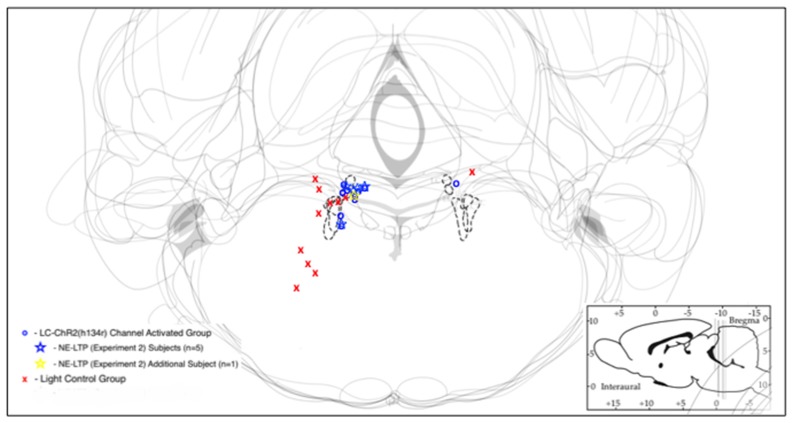
Schematic representations of LC with optrode placements designated by symbols. Blue/yellow symbols represent optrode placements that successfully produced light activation of the recorded cells. Red symbols indicate optrodes that did not produce light activation of recorded cells. Sites at which long-term potentiation (NE-LTP) experiments were conducted are indicated by stars. The dashed lines indicate the outlines of LC in each respective section.